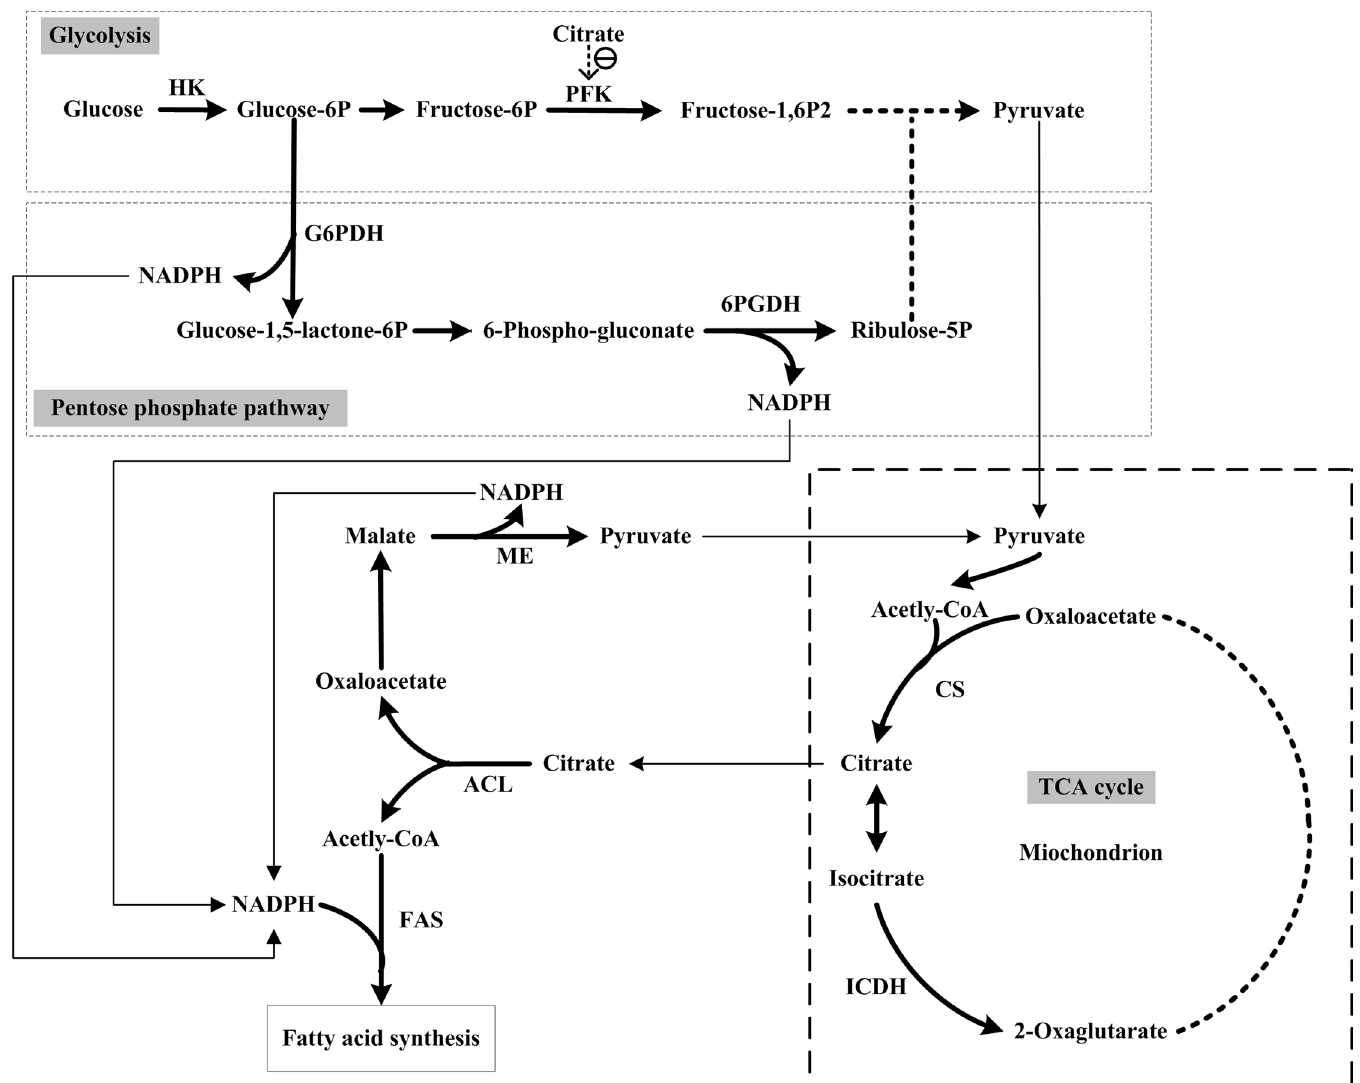
Fig 1. Network of fatty acid biosynthesis in oleaginous eukaryotic microorganisms. HK, hexokinase; PFK, phosphofructokinase; G6PDH, glucose- 6-phosphate dehydrogenase; 6PGDH, 6-phosphogluconate dehydrogenase; CS, citrate synthase; ICDH, isocitrate dehydrogenase; ACL, ATP:citrate lyase; ME, malic enzyme; FAS, fatty acid